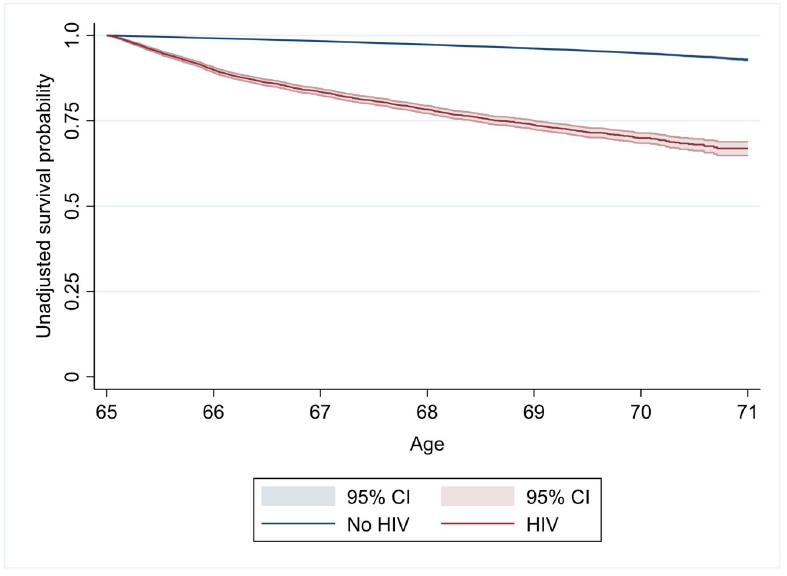
Fig 1. Kaplan-Meier plot of unadjusted survival by HIV status. Years since age 65.